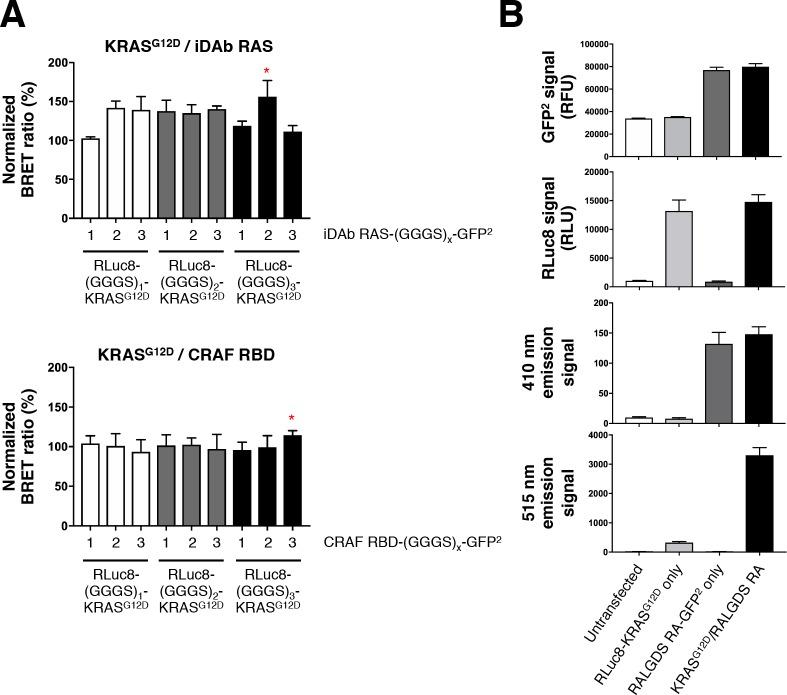
Optimization of the RAS biosensors.(A) Optimization of the donor and acceptor linker length. Top panel shows KRASG12D/iDAb RAS optimization and the bottom panel shows KRASG12D/CRAF RBD optimization. The red stars indicate the linker length chosen for the study: all RLuc8-RAS constructs bear a (GGGS)3 linker, the iDAb-GFP2 fusions a (GGGS)2 linker and all effectors fused to the GFP2 moiety a (GGGS)3 linker. (B) Background analysis with total GFP2 and RLuc8 levels, emission signal at 410 nm and at 515 nm upon coelenterazine 400a addition from untransfected cells, RLuc8-KRASG12D transfected cells only, RALGDS RA-GFP2 transfected cells only and cells transfected with the BRET pair KRASG12D/RALGDS RA. Each experiment was repeated twice (A–B). Where error bars are presented, they correspond to mean values ± SEM of biological repeats.